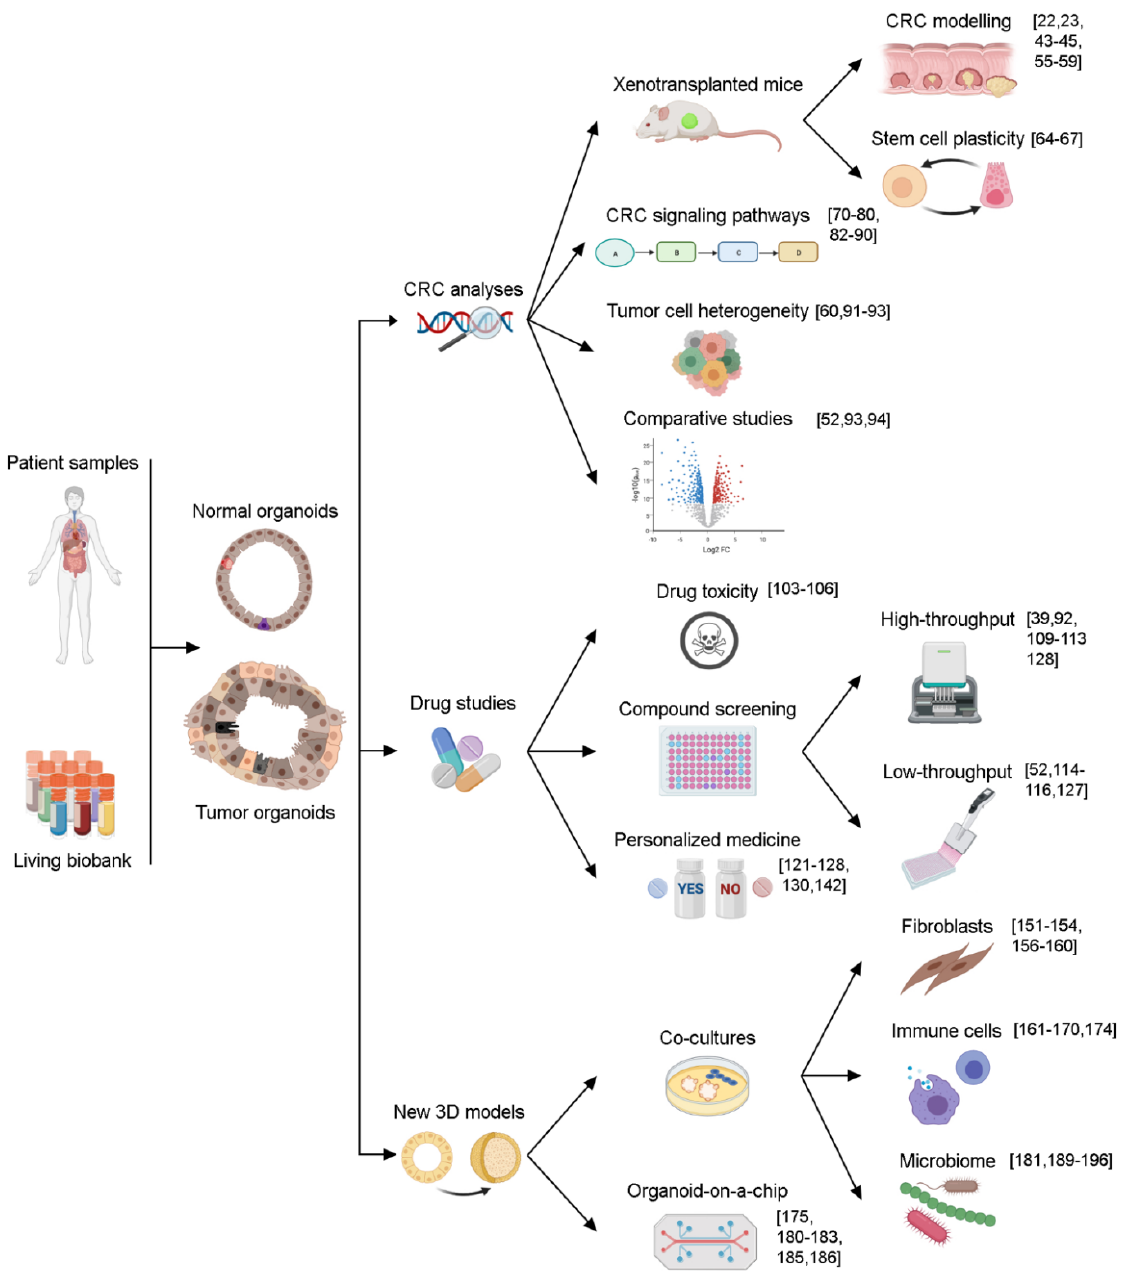
Figure 2. Schematic representation of the uses of normal and tumor organoids for CRC basic and clinical research. References of the original studies are shown in square brackets. Created with Biorender.com (accessed on 27 April 2021).